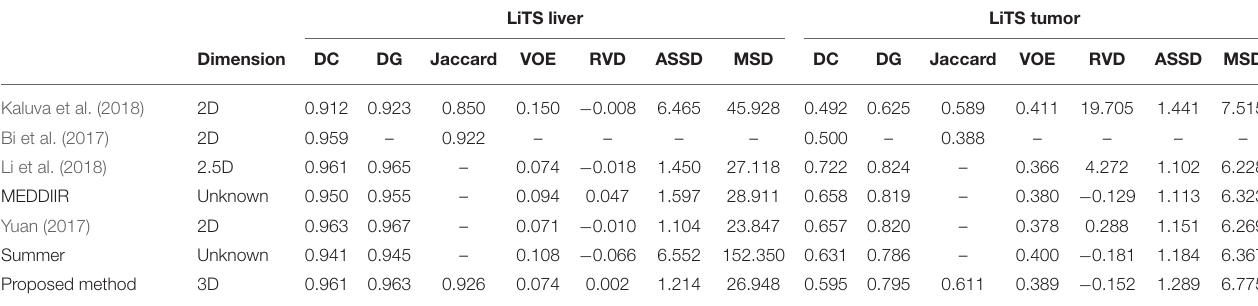
TABLE 5 | Segmentation results compared with other methods on the LiTS test